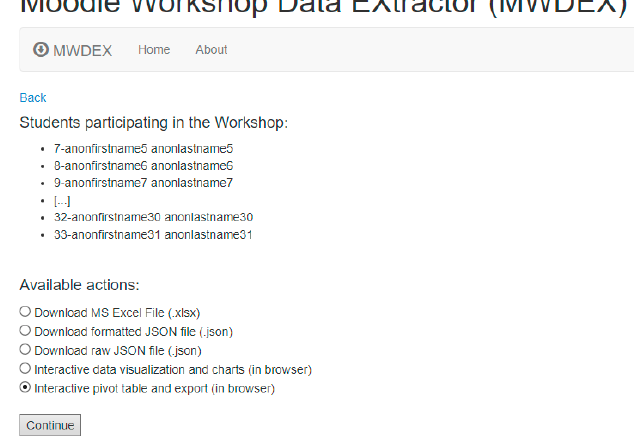
Figure 7. List of enrolled students (edited due to size limitations) and output selection.